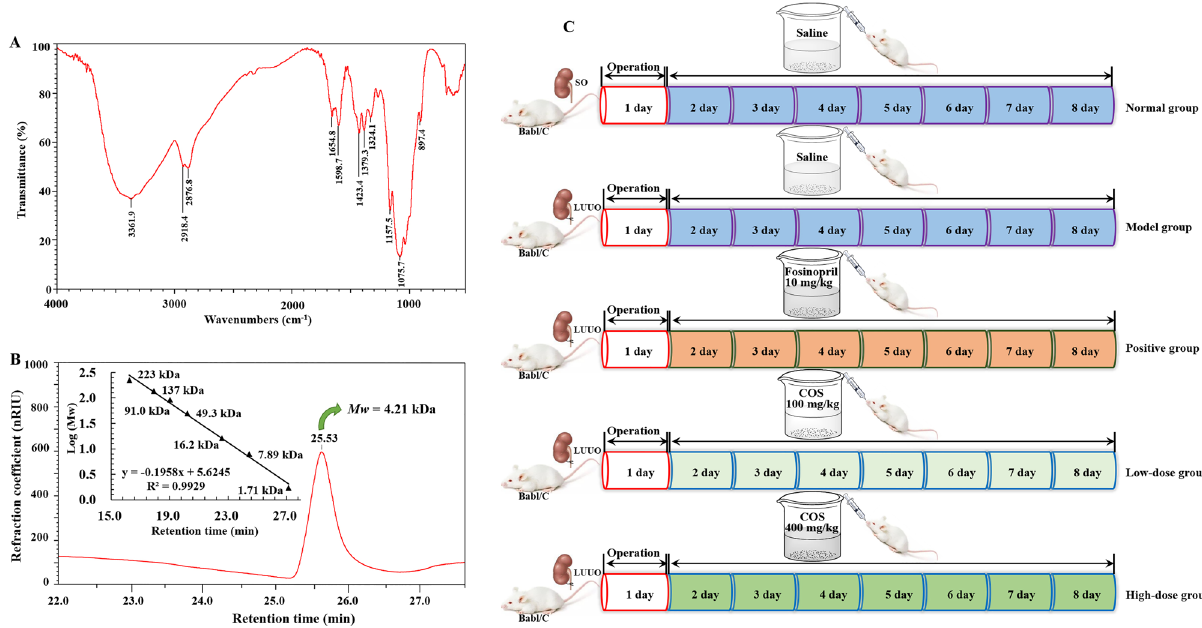
Figure 8. FT-IR spectrum ( A ), HPGPC and standard curve of molecular weight determination ( B ) of COS, and its intervention program design ( C